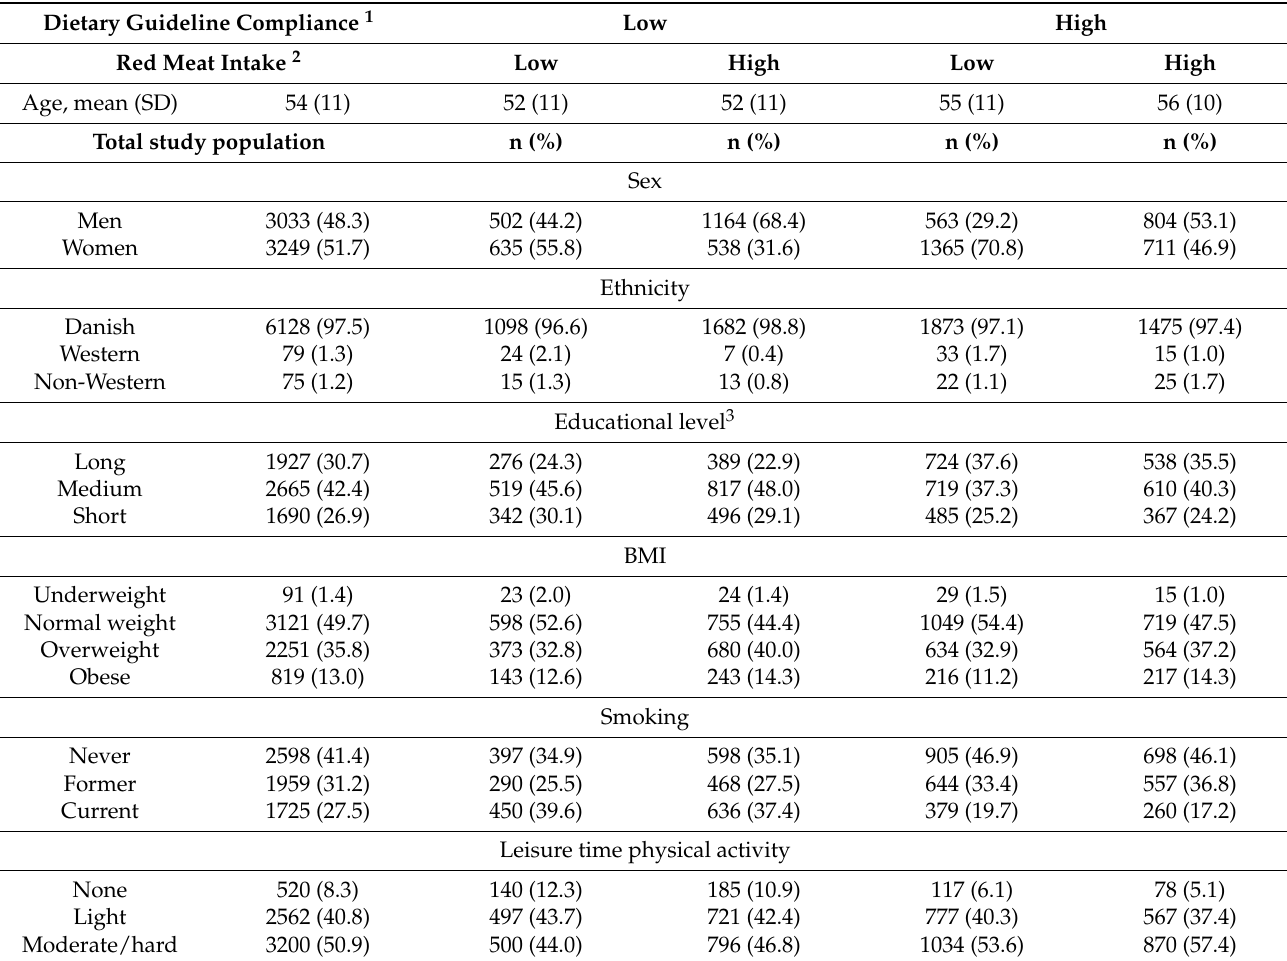
Table 1. Baseline characteristics of the colorectal cancer study population stratified by dietary guideline compliance and intake of red meat, n = 6282.